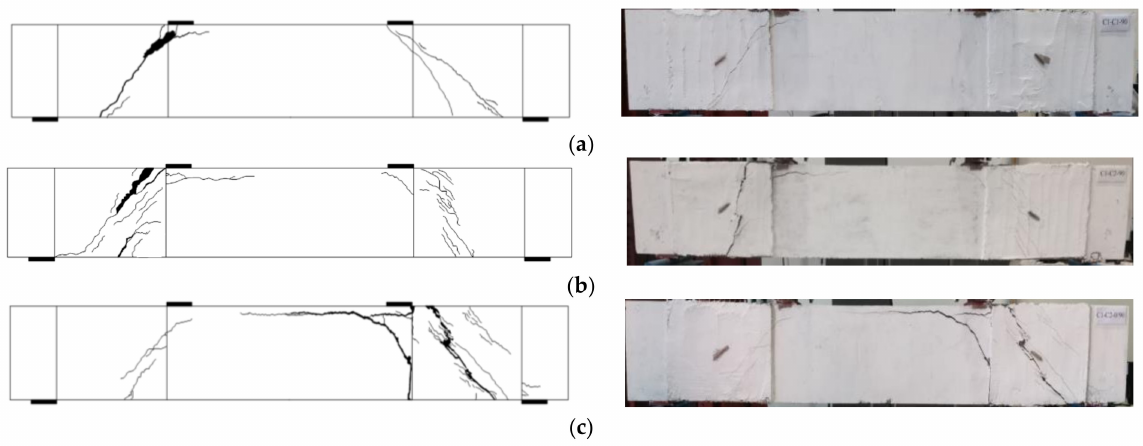
Figure 6. Crack pattern at failure of the unstrengthened specimens: ( a ) Control-NS; ( b ) Control-ST.